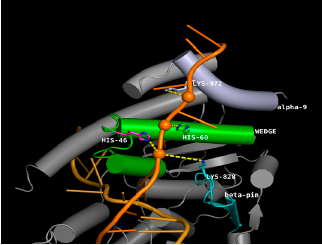
Figure 9. Model of activated ERCC5 using the DNA in the T4 RNase H crystal structure (PDB 2IHN). Close-up views of the gateway and the canyon from the model shown in panel B. Residues mutated in silico are colored in magenta. The undamaged ssDNA fits in the crevice formed by the hydrophobic wedge (green), the β -pin motif (cyan) and α -helix 9 (light blue). The crevice accommodates the phosphate backbone and is stabilised by charge interactions with bottom Lys828, His80 and Lys972; the MD simulation also showed wedge flexible loop to participate in binding by His46 driven closure onto the phosphate backbone. The His46Gln mutant largely lost such